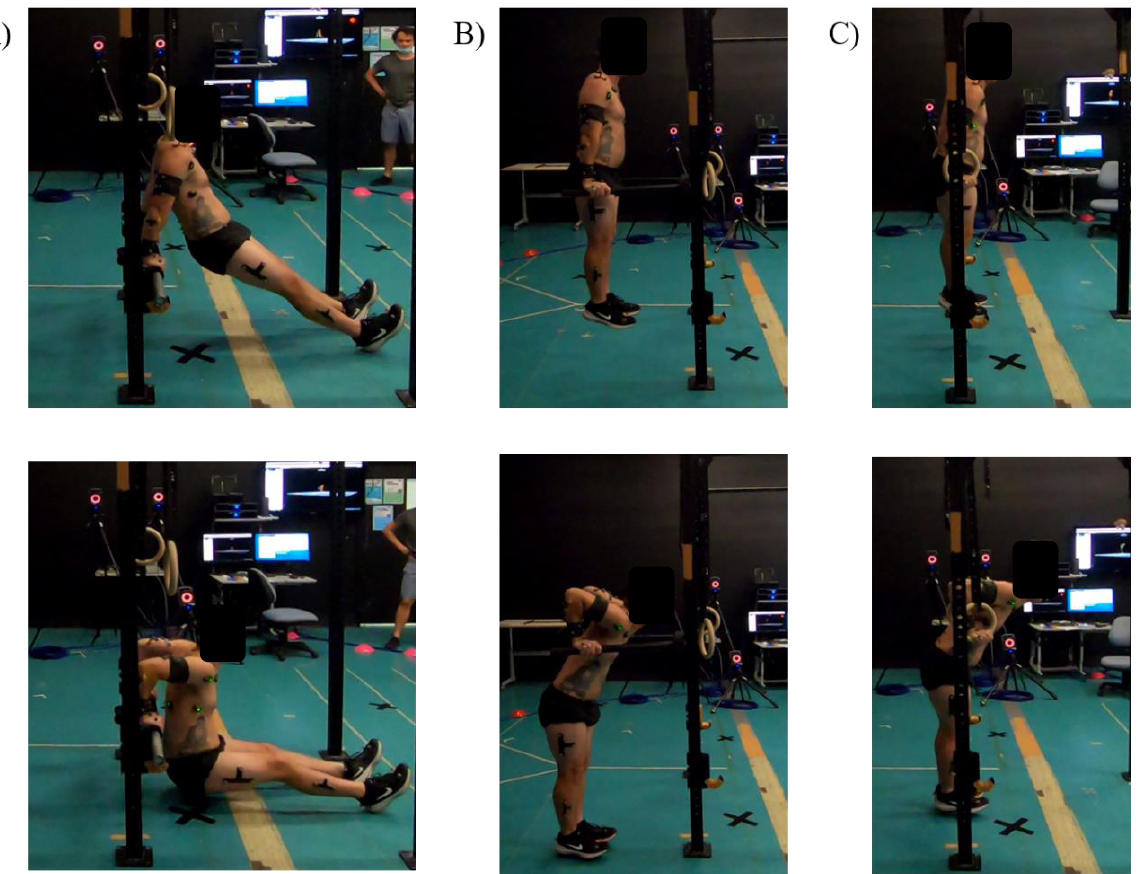
Figure 1. Typical starting position ( top row) and bottom position ( bottom row) for the ( A ) bench dip, ( B ) bar dip, and ( C ) ring dip.